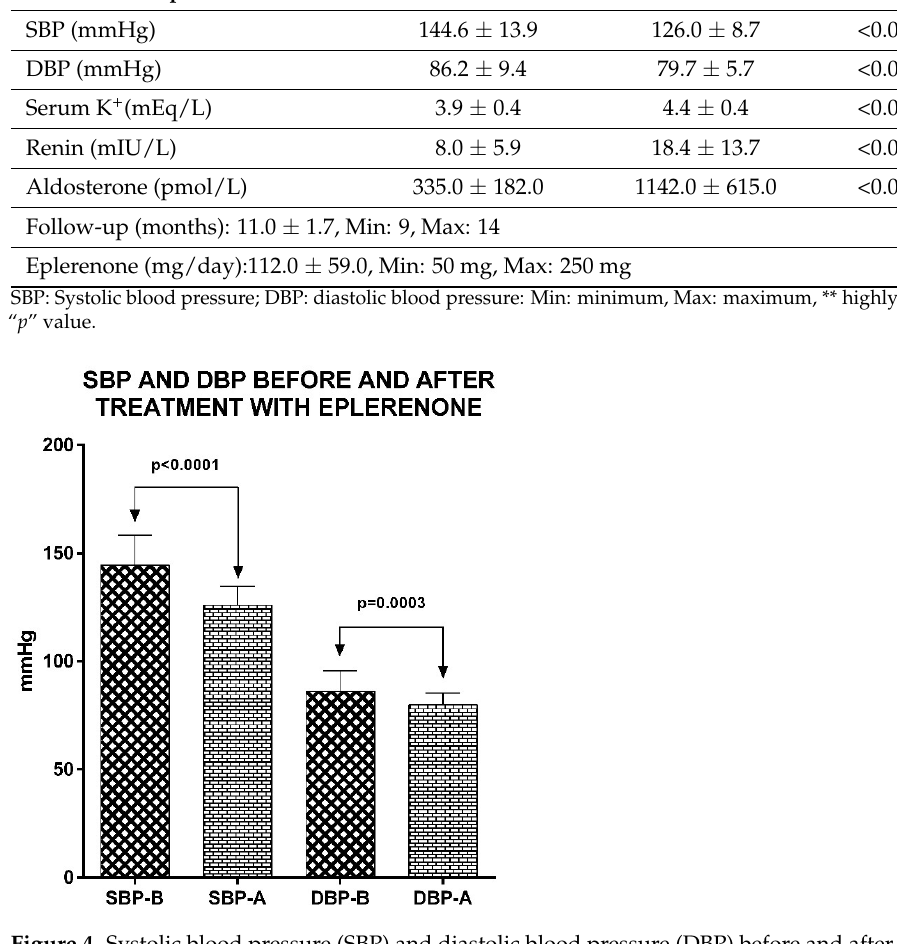
Figure 4. Systolic blood pressure (SBP) and diastolic blood pressure (DBP) before and after treatment with eplerenone either alone or in combination with other anti-hypertensive drugs.